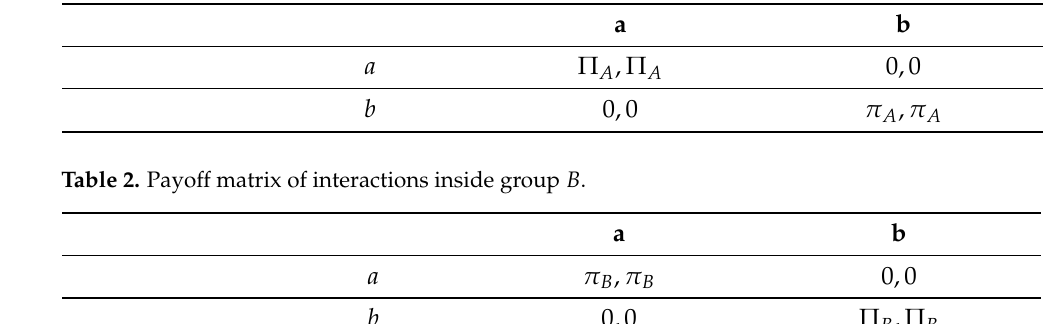
Table 1. Payoff matrix of interactions inside group A .